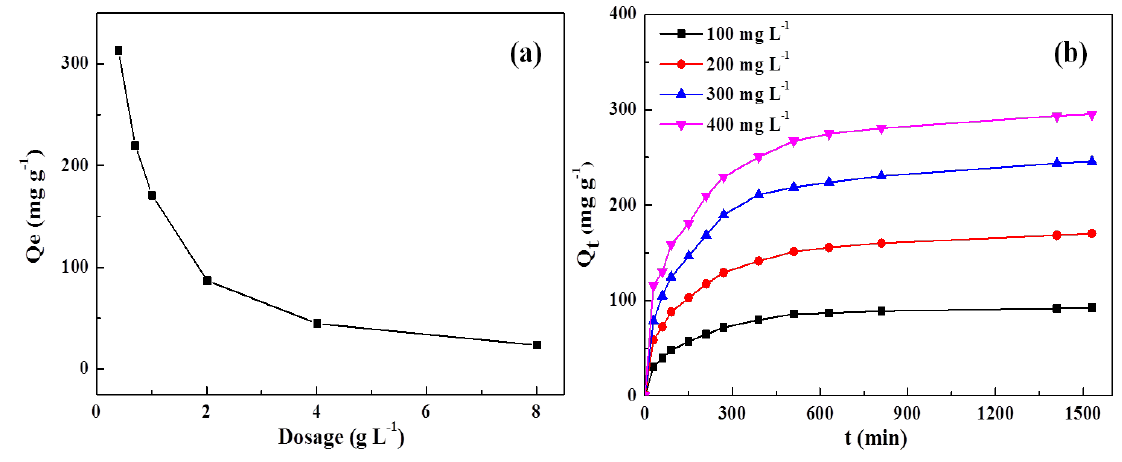
Figure 8. Effects of ( a ) dosage of adsorbent and ( b ) contact time on the MB adsorption.